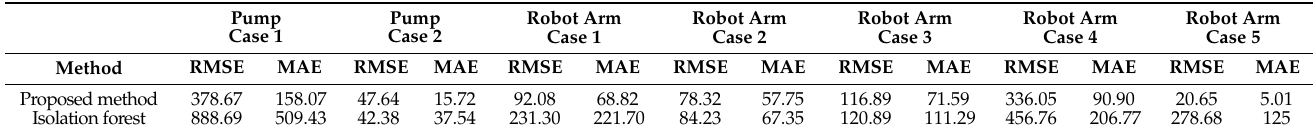
Table 2. The result of additional